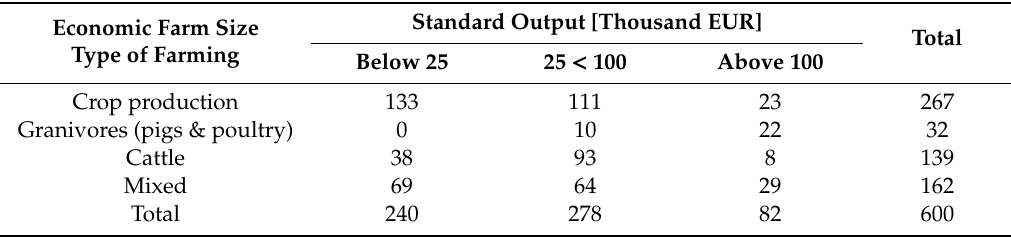
Table 2. Number of farms in test sample regarding economic size and type of